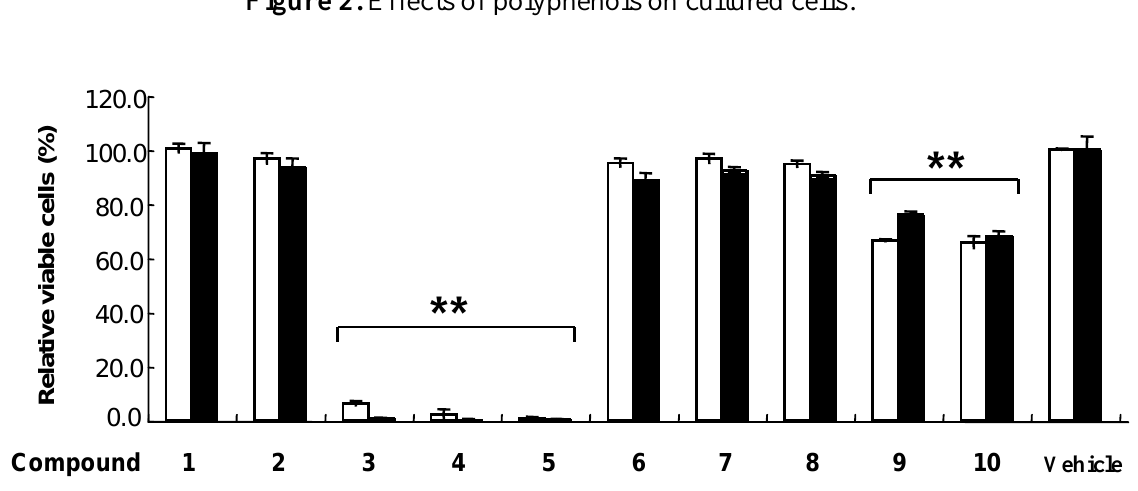
Figure 2. Effects of polyphenols on cultured cells.